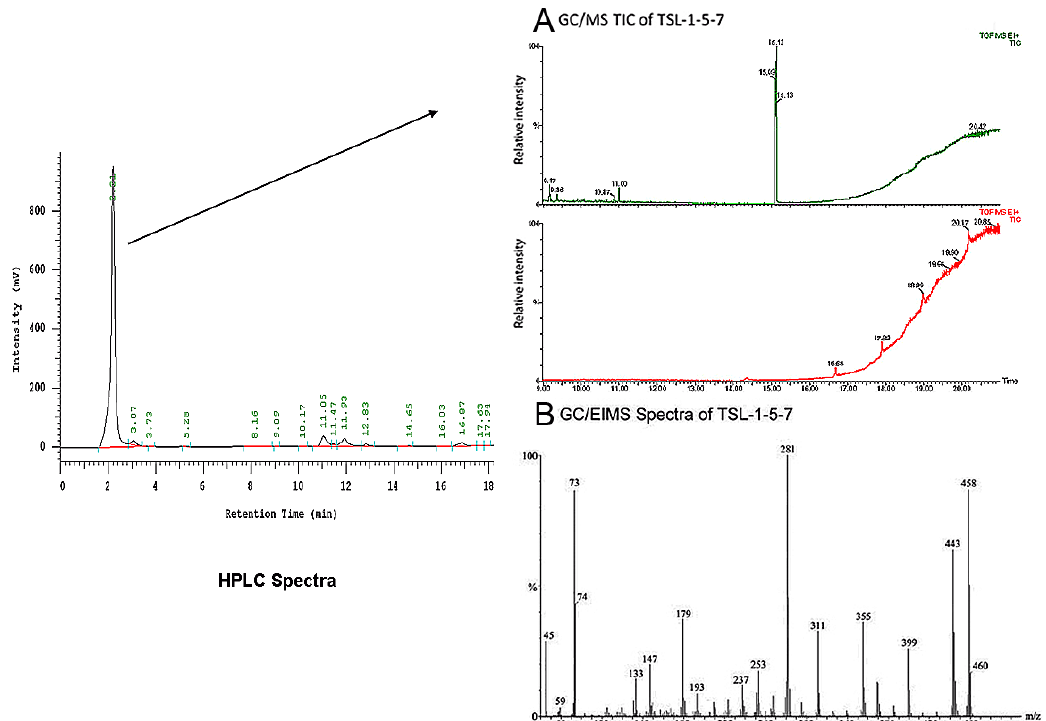
Figure 3. Spectra of